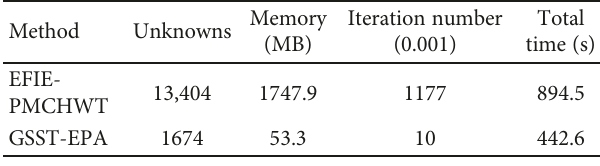
Table 1: The computational results of two methods.